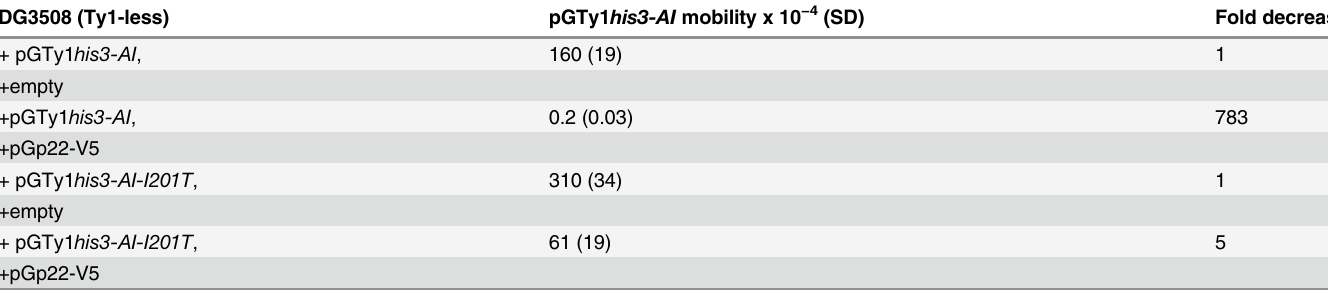
Table 3. CNC-resistant pGTy1 his3-AI mobility when co-expressed with p22-V5. DG3508